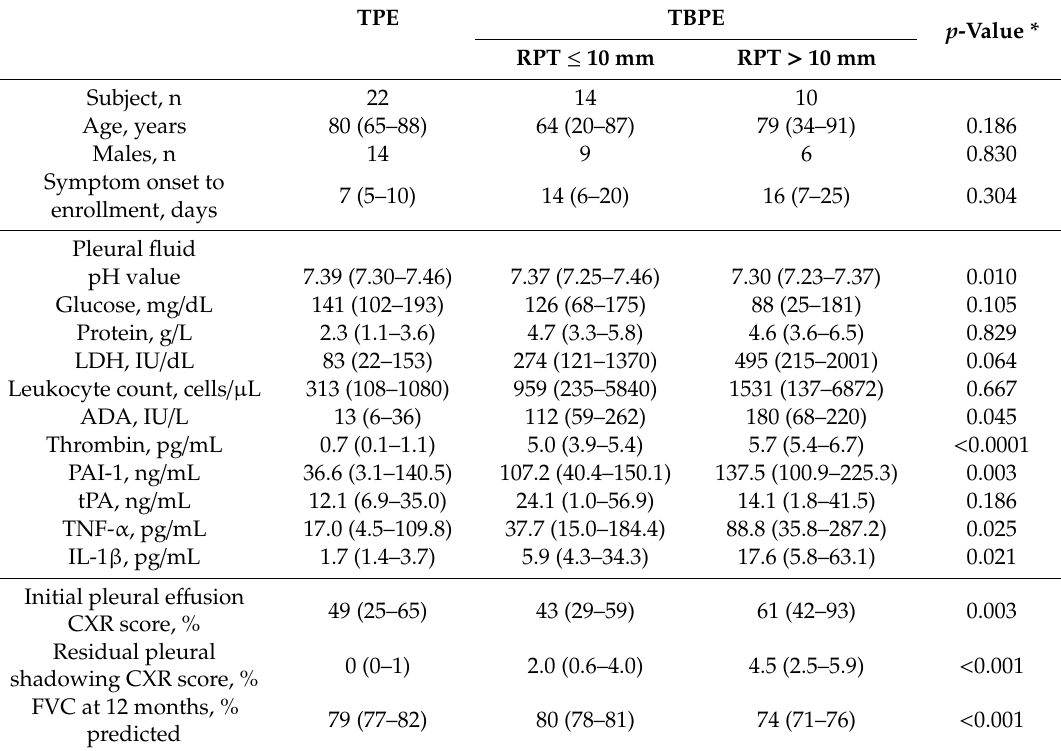
Table 1. Demographics, pleural fluid characteristics, and e ff usion levels of thrombin, fibrinolytic factors and cytokines among all patients ( n = 46) † .